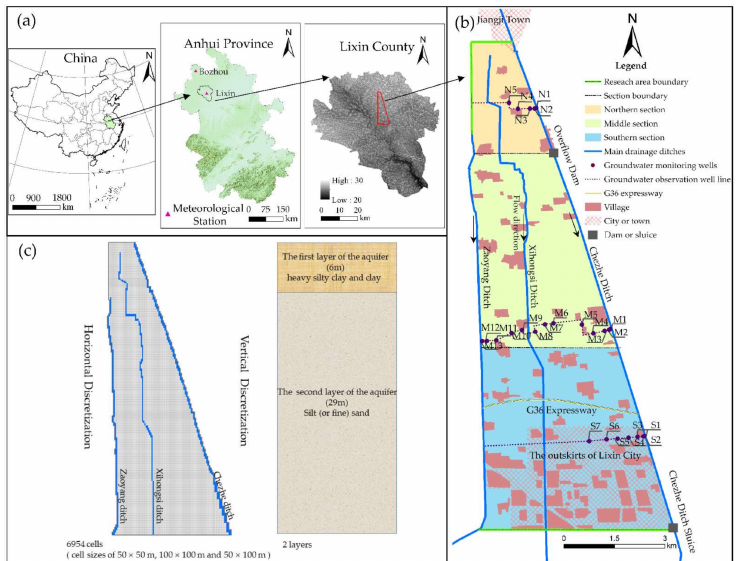
Figure 1. Overview of the study area. ( a ) Location of the study area. ( b ) Study area in detail, with the ditches, monitoring wells and sections in the location of the study area. The topographic map of Anhui Province was obtained from the National Administration of Surveying, Mapping and Geographic Information of the People’s Republic of China (http://www.nasg.gov.cn/, accessed on 20 September 2021). The DEM source of the Lixin city was obtained from the NASA (National Aeronautics and Space Administration) website (http://reverb.echo.nasa.gov/reverb/, accessed on 20 September 2021). ( c ) Conceptual model